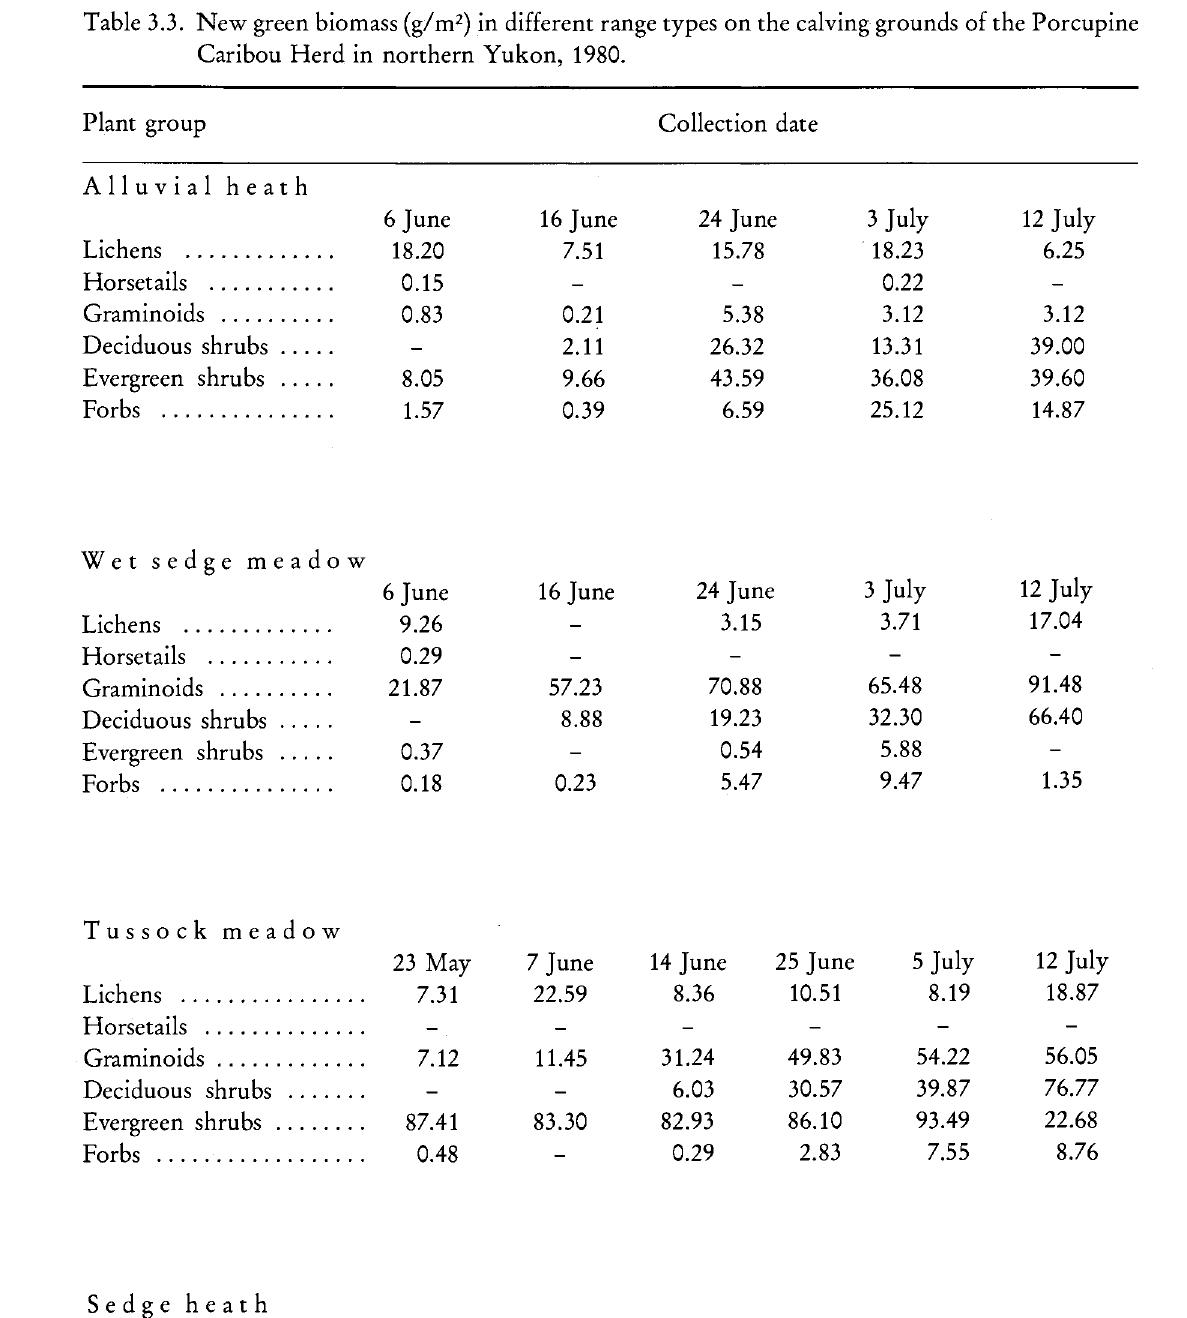
Table 3.3. New green biomass (g/m 2 ) in different range types on the calving grounds of the Porcupine Caribou Herd in northern Yukon,